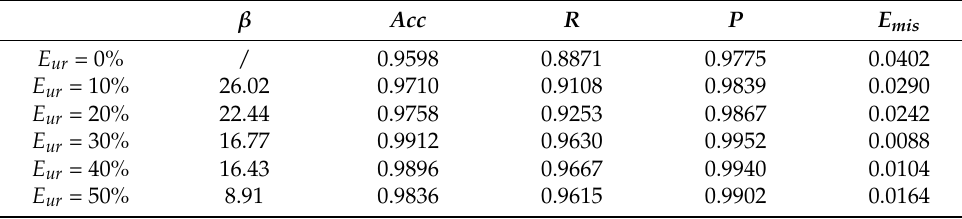
Table 8. Performance of three-way decision on the Thyroid Disease